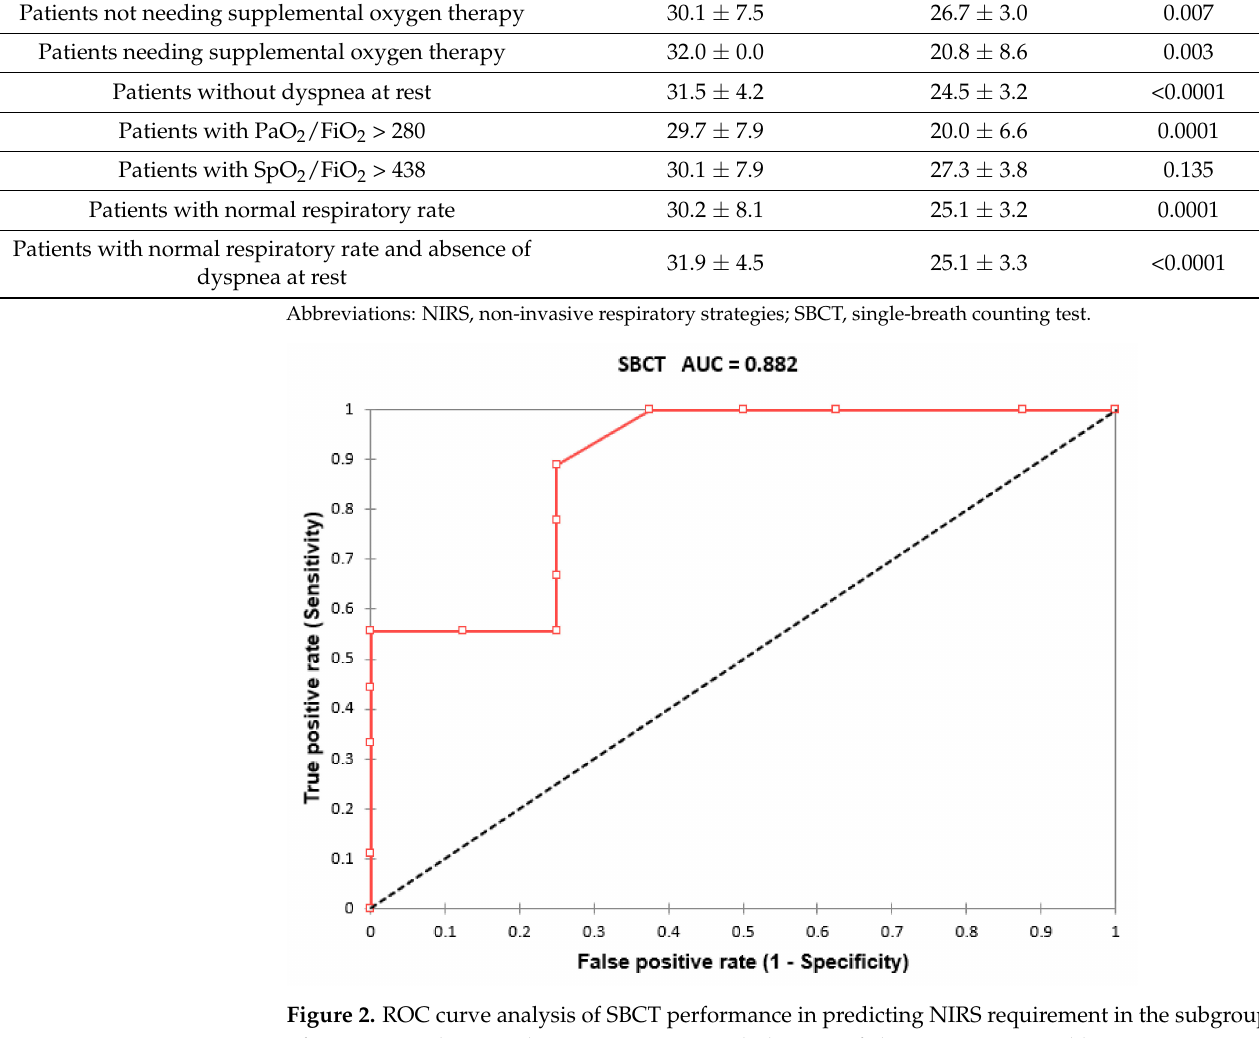
Figure 2. ROC curve analysis of SBCT performance in predicting NIRS requirement in the subgroup of patients with normal respiratory rate and absence of dyspnea at rest. Abbreviations: NIRS, non-invasive respiratory strategies; SBCT, single-breath counting